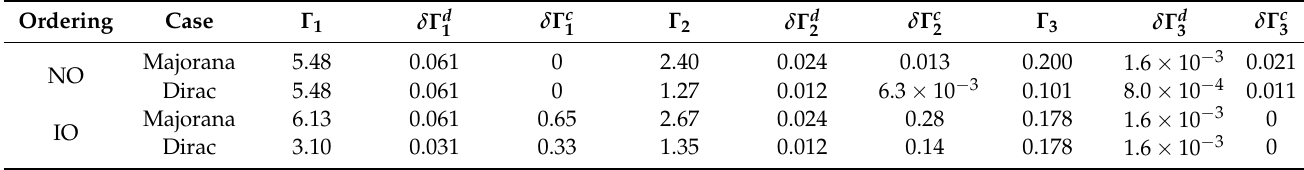
Table 9. Capture rates of relic cosmic neutrinos on 100 g of tritium in unit of year − 1 with m lightest = 0. δ Γ d is the differences between the cases with and without effects of e ± -annihilation during neutrino i decoupling and δ Γ c is the differences with and without gravitational clustering for relic neutrinos in i nearby